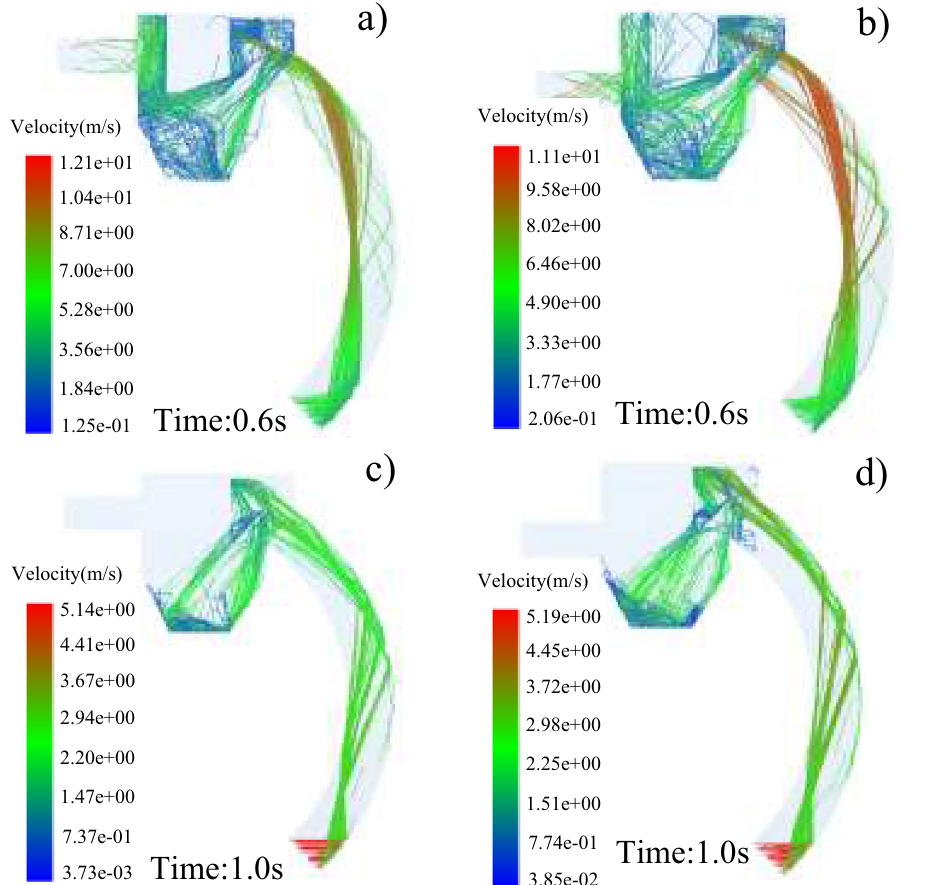
Figure 19. Comparison of outlet pipeline position optimization before and after: ( a ) distribution of waste particle velocity before optimization. ( b ) Distribution of waste particle velocity after optimization. ( c ) Velocity distribution of steel pellets before optimization. ( d ) Velocity distribution of steel pellets after